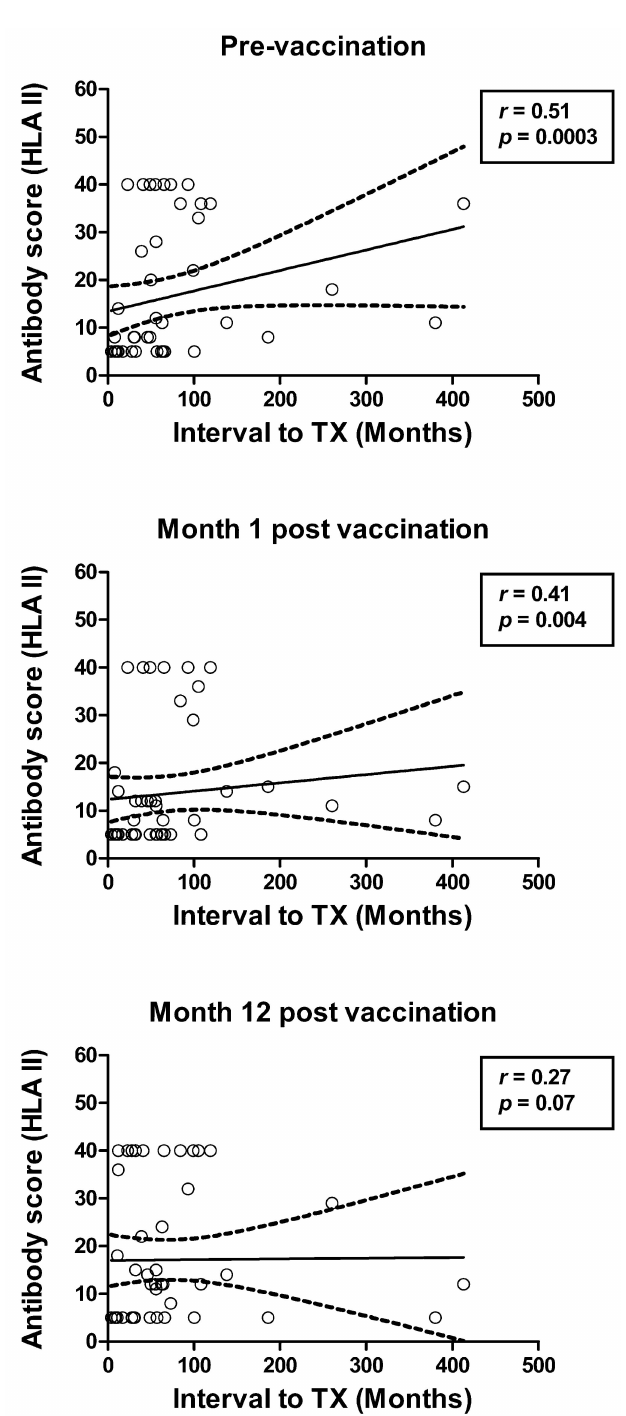
Figure 5. Spearman correlation analysis of the interval between kidney transplantation (TX) and vaccination and HLA class II (HLA II) antibodies. The antibody score is the sum of responses to HLA class II Luminex ™ Mixed beads. Correlation analyses were performed two-tailed prior to and at month 1 and 12 after vaccination with Prevenar ( n = 47). The continuous line represents the regression line, the broken lines the 95% confidence